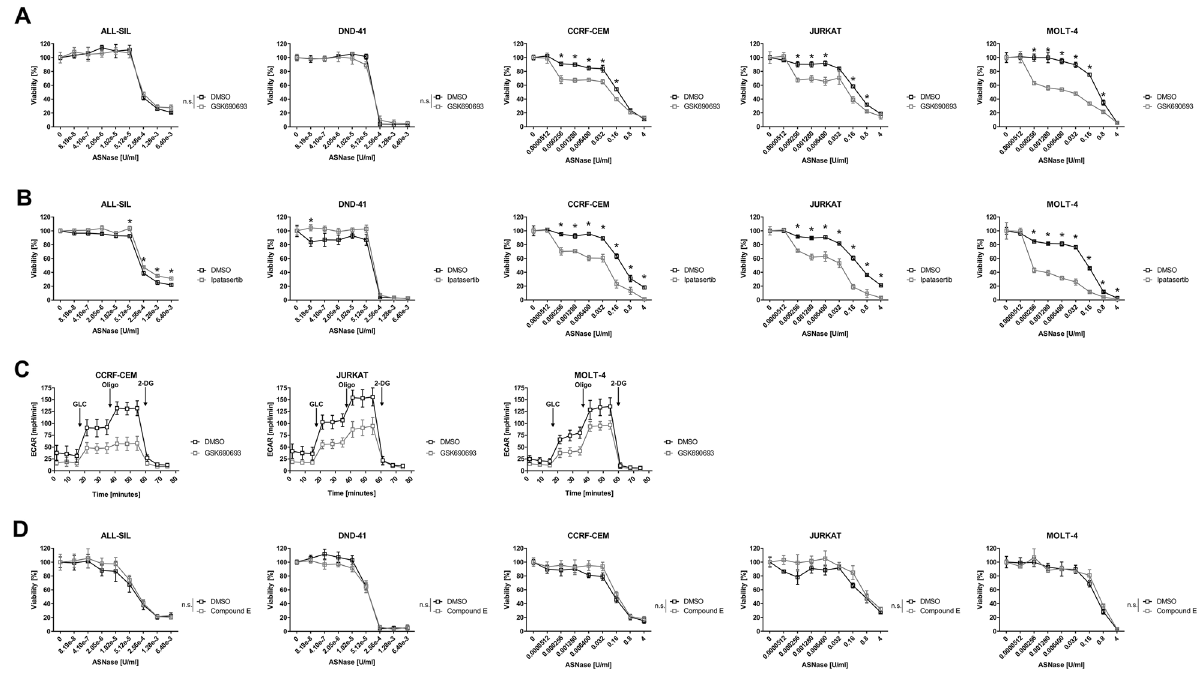
Figure 3. Functional study on the Akt and NOTCH1 inhibition in T-ALL cell lines. The effect of the Akt inhibitor ( A ) 1 µM GSK690693 and ( B ) 1 µM Ipatasertib on the sensitivity of ALL-SIL, DND-41, CCRF-CEM, JURKAT and MOLT-4 cell lines to ASNase. ( C ) Effect of the Akt inhibitor (1 µM GSK690693) on the glycolytic profile in CCRF-CEM, JURKAT and MOLT-4 cell lines was determined using Seahorse XFp analyzer and Glycolysis Stress Test. ( D ) The effect of the NOTCH1 inhibitor (100 nM Compound E) on the sensitivity of ALL-SIL, DND-41, CCRF-CEM, JURKAT and MOLT-4 cell lines to ASNase. Cells were co-treated with ASNase and GSK690693, Ipatasertib or Compound E for 72 h and the sensitivity to ASNase was determined based on MTS assays. All MTS assays were done at least in biological triplicates and six technical replicates. The Seahorse measurements were done at least in biological triplicates and six technical replicates. All the results are presented as a mean ± SD. * = FDR < 0.1%, n.s. not